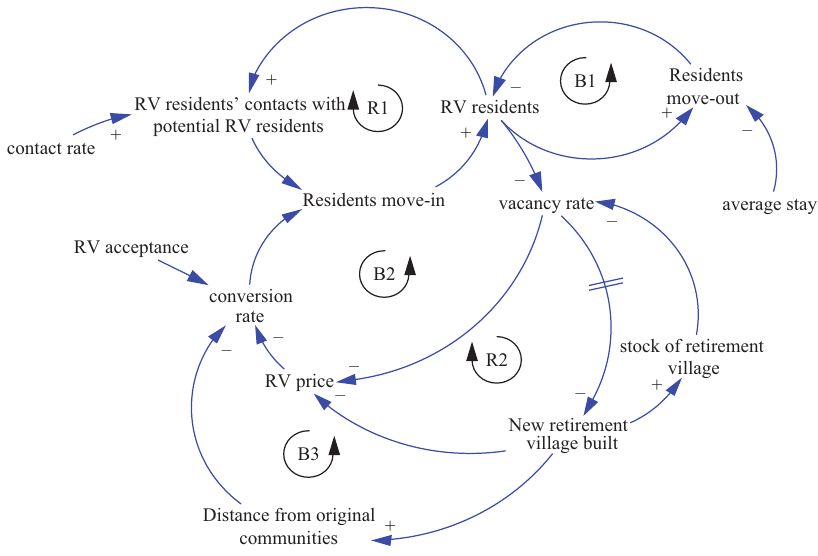
Figure 3. Causal loop analysis of the future growth of the Australian RV